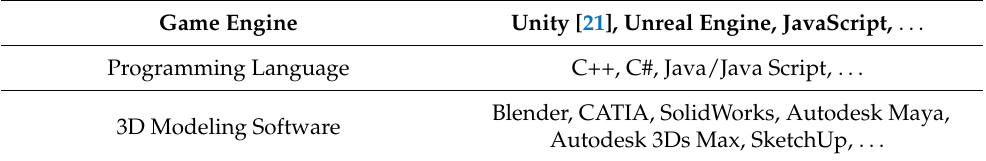
Table 1. Commonly used software for MR